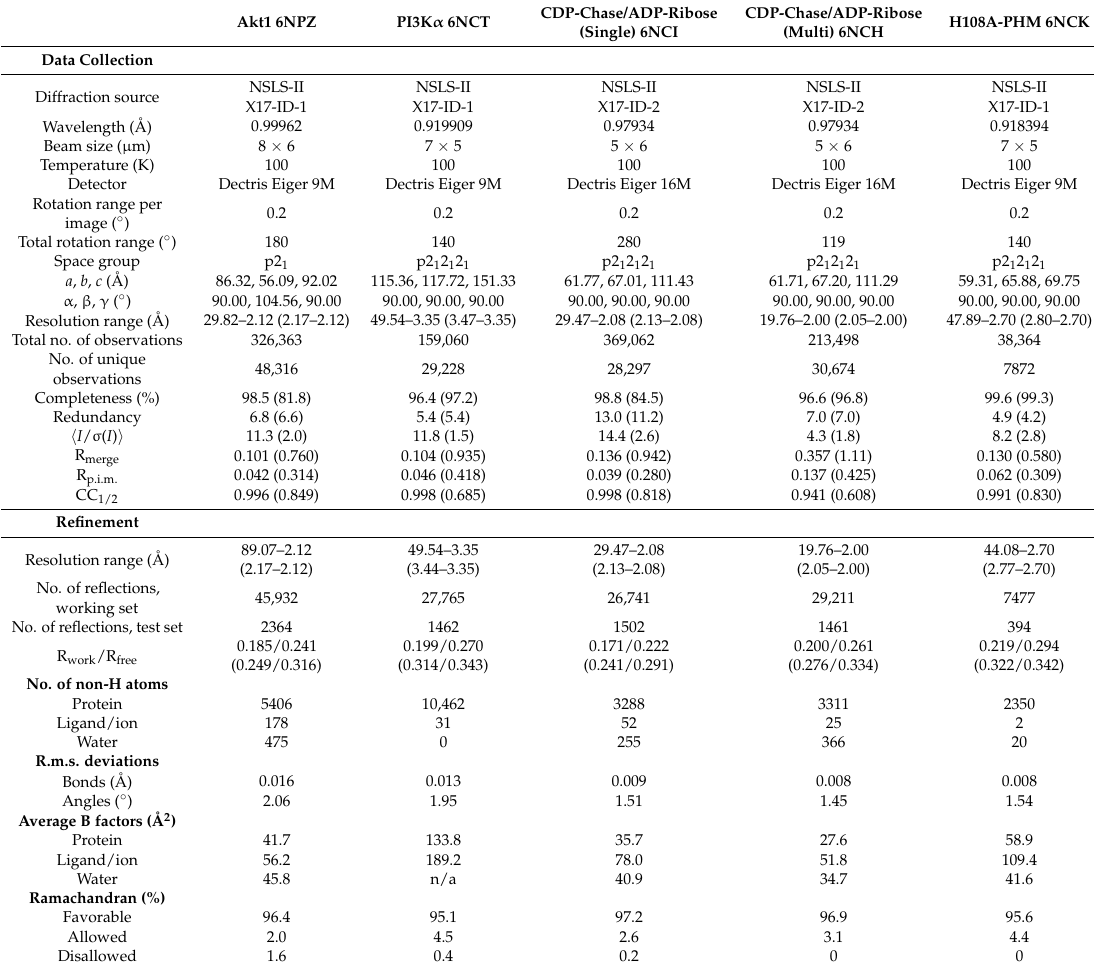
Table 1. Data collection and refinement statistics.